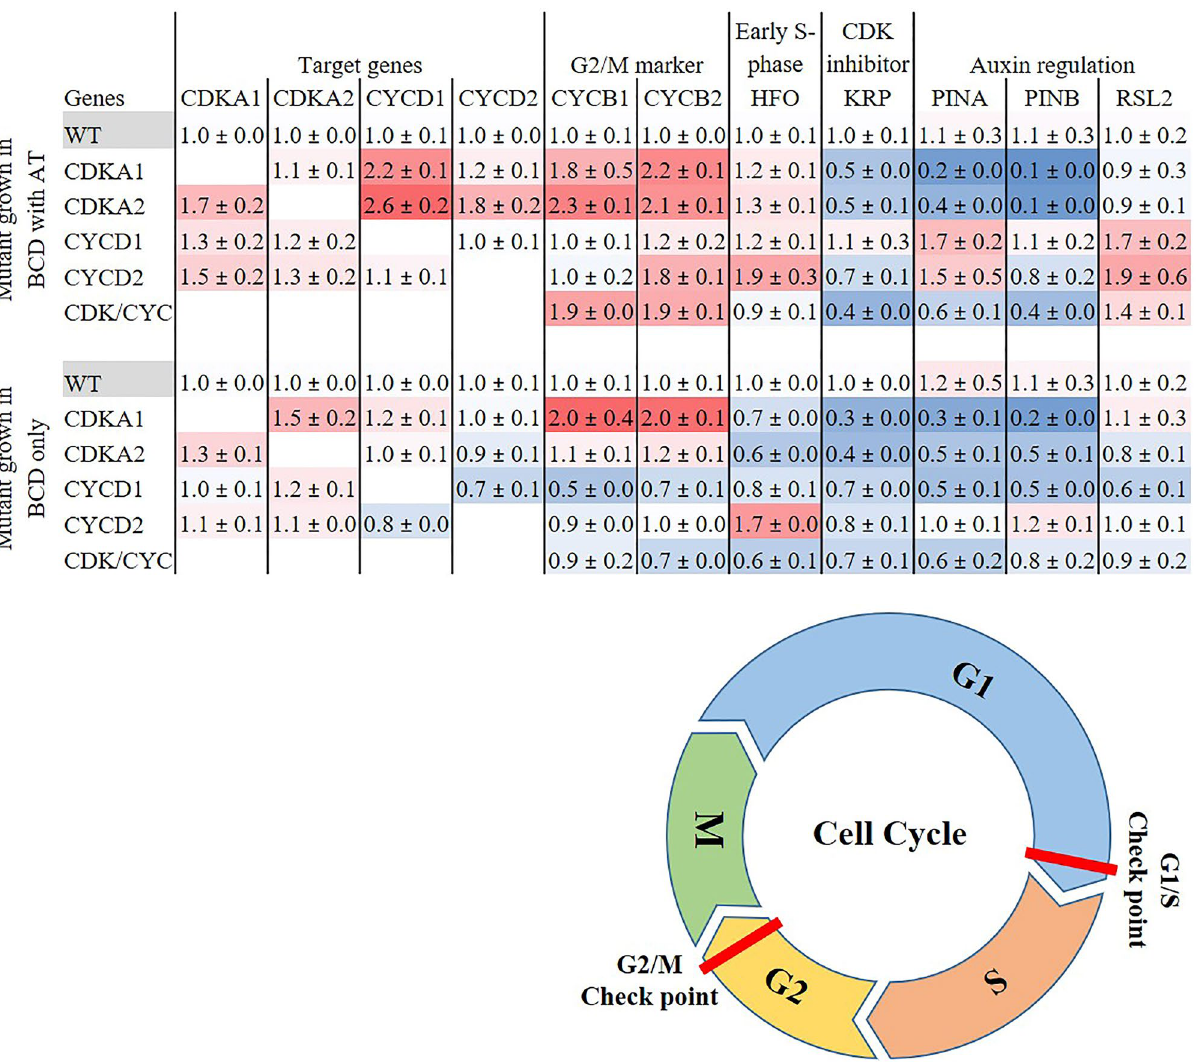
grown in BCD and BCDAT were 1.7 and 1.6 times taller; and with larger leaf cell area on BCD media when compared to the WT (Table 1). The significant growth in gametophore height can in part be related to the increased expression of PpPINA and PpRSL2 transcript levels (Fig. 2), which regulates the differentiations into gametophores and more new buds as also seen in Arabidopsis 17 . The G2-M markers CYCB1 + 2, the CDKA/CYCD complex suppresser KRP (KIP-RELATED PROTEIN) and early S phase marker HFO (histone H4 gene) were significantly downregulated in ZmUbi:PpCYCD1 cells grown on BCD (Fig. 2), whereas no significant differences were observed in cells on BCDAT (Fig. 2). A previous finding of P. patens gametophores hypothesized that gametophore cells tend to arrest in the late S phase 5 , and the observed increase in the size and numbers of gametophore cells together with low expression of CYCB1 + 2, HFO supports the previous finding. Overall these observations show that PpCYCD1 is likely to be involved in the G1 to S phase transition. The gametophore cell area increased for all ZmUbi:PpCDKAs and ZmUbi:PpCYCD1 lines grown in BCD media. The ZmUbi:PpCYCD1 line had the most significant increase in gametophore cell area of 35% (Table 1). The cell area growth in plants could be under a cell cycle-related or cell cycle-independent regulation 16 . The